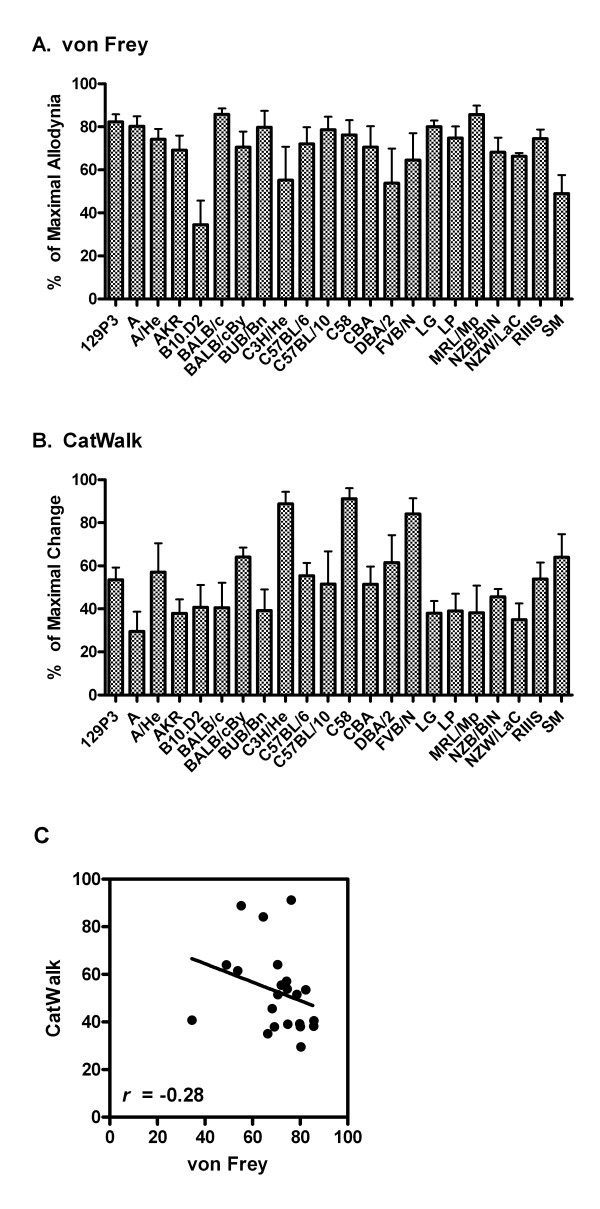
Genetic dissociation between mechanical allodynia and dynamic weight bearing (gait) changes following SNI injury in 22 inbred mouse strains. Bars represent mean ± S.E.M. (A) percentage of maximal allodynia and (B) percentage of maximal weight bearing (mean paw print intensity; see Fig. 4B) change, in each strain separately, over 28 days post-operatively, calculated as areas over the time-effect curve using the trapezoidal rule. Robust strain differences (p < 0.001) were obtained for both measures; the individual pattern of strain responses is the subject of a manuscript in preparation. The non-significant correlation between these two measures is shown in graph C; symbols represent individual strains. Note that the trend towards a negative correlation would argue against genetic variability in allodynia and gait changes being produced by similar gene variants.